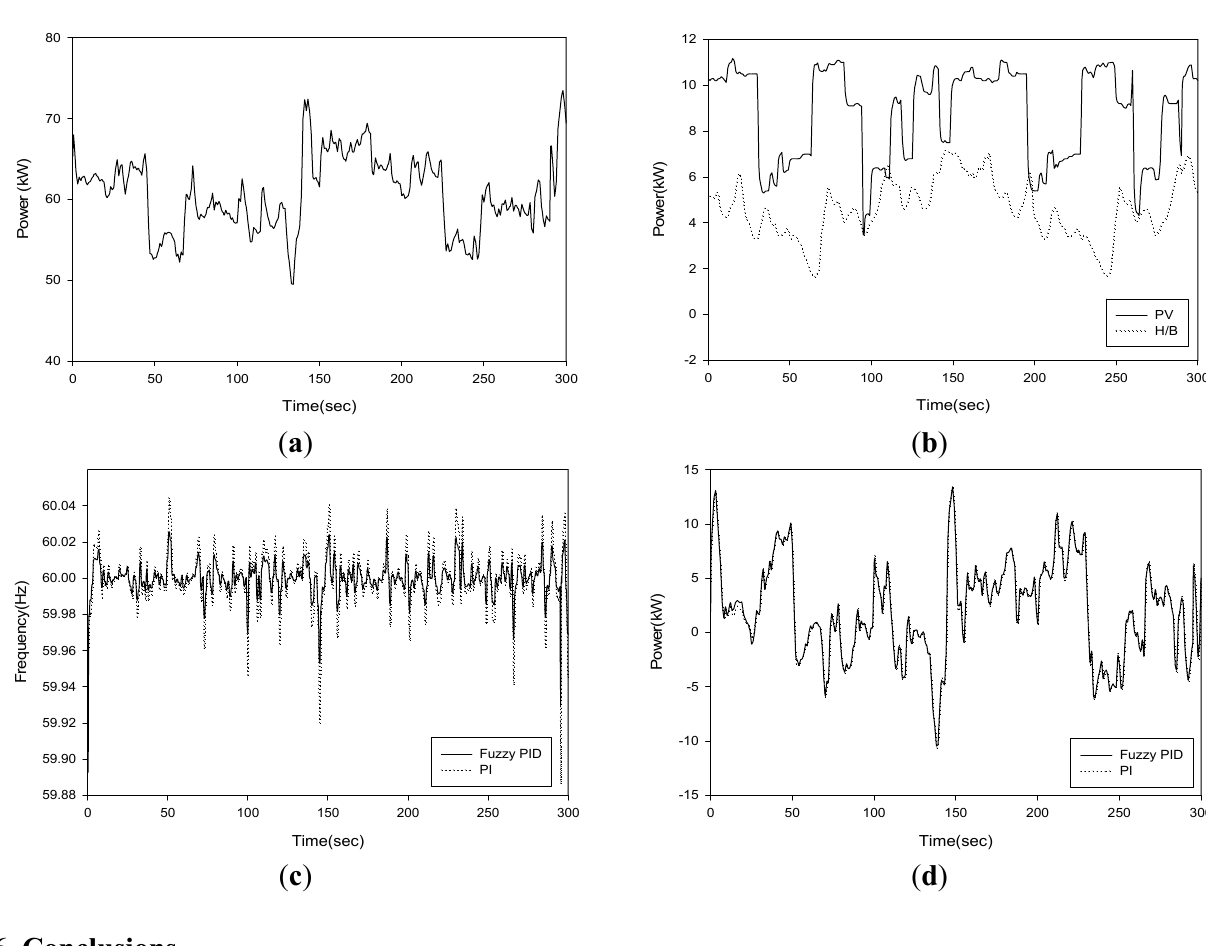
Figure 17. Simulation results in Case C: ( a ) Active load; ( b ) Power outputs of RES; ( c ) Frequency deviation; ( d ) Power outputs of